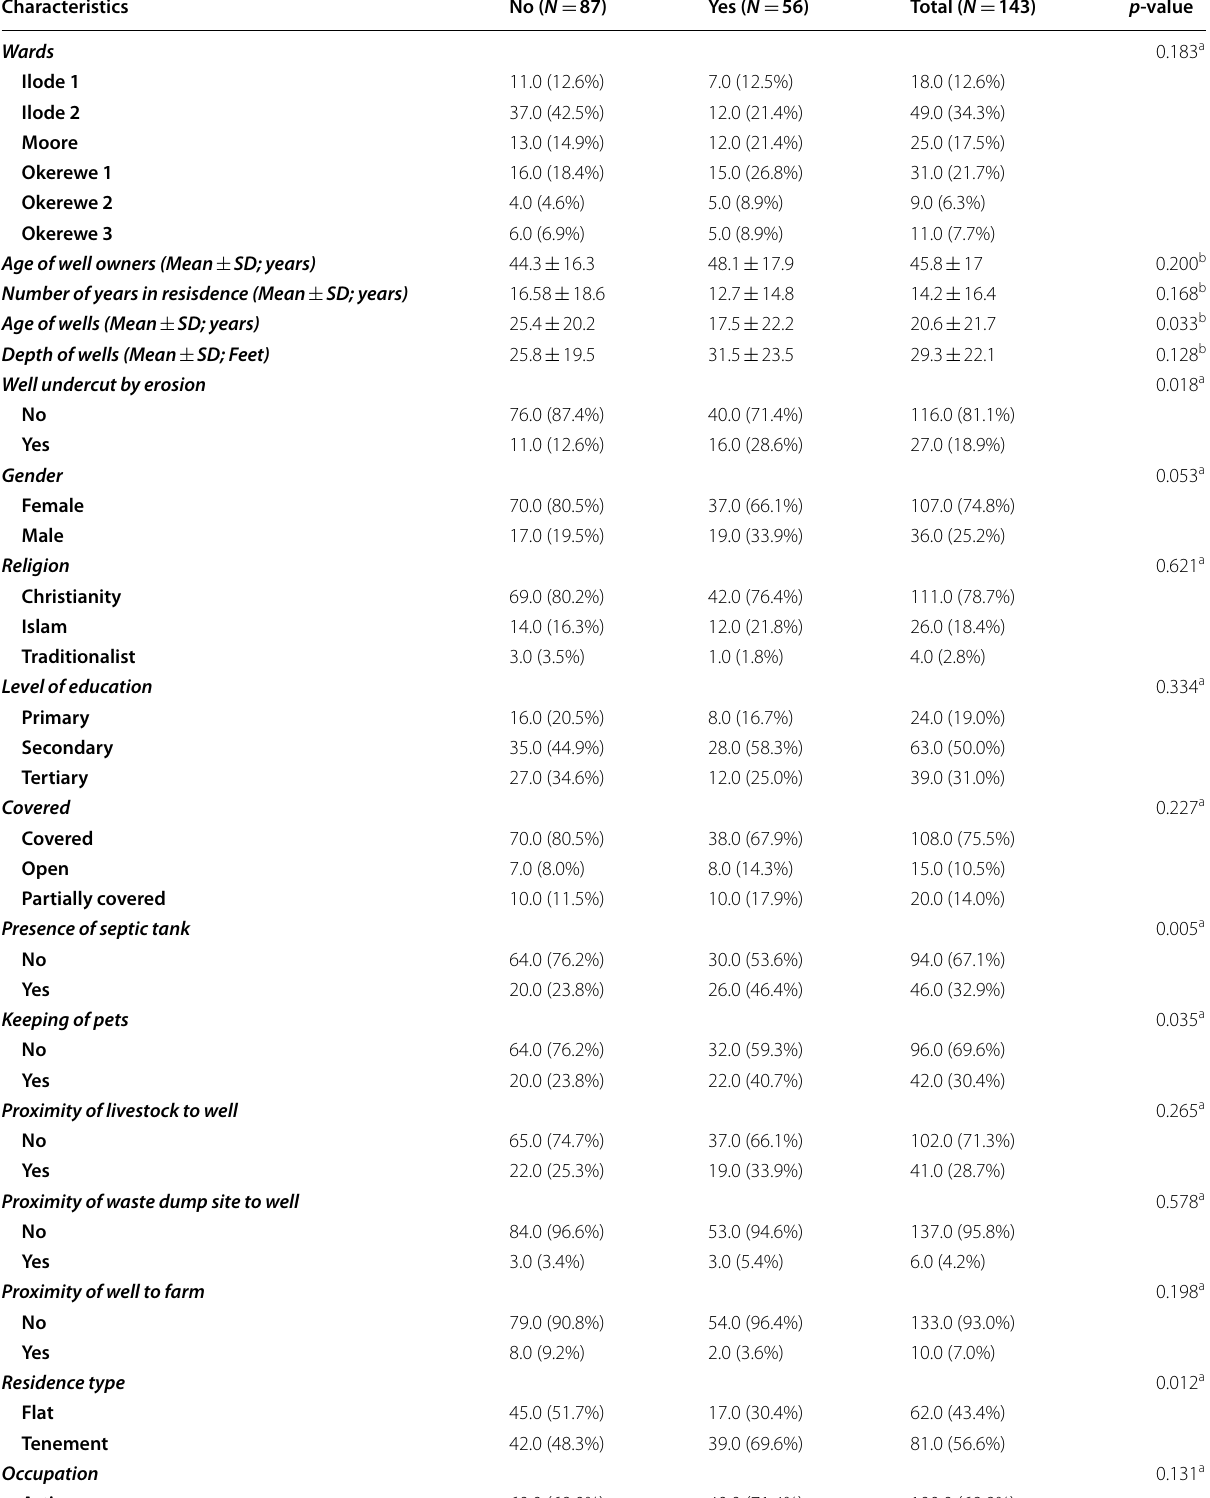
Table 6 Univariate analysis of risk factors for contamination with DEC